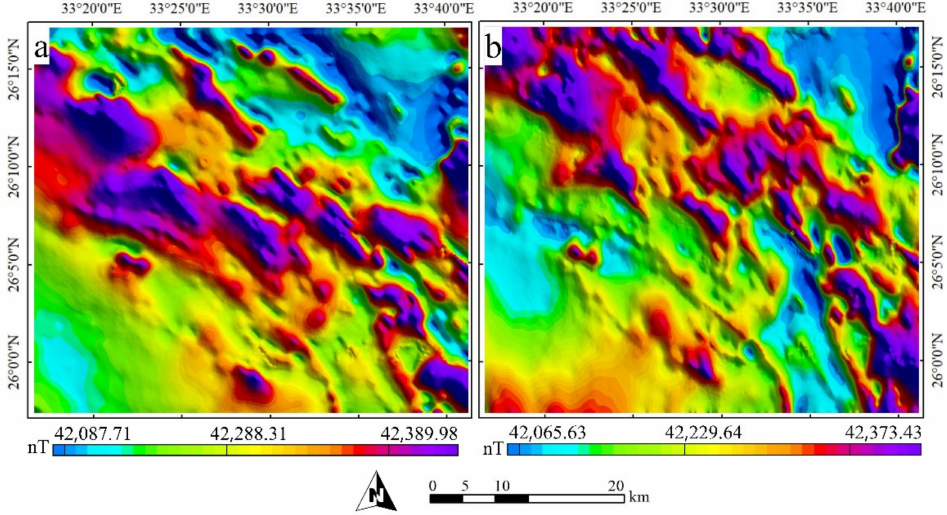
Figure 3. ( a ) Total magnetic intensity map, and ( b ) reduction to pole